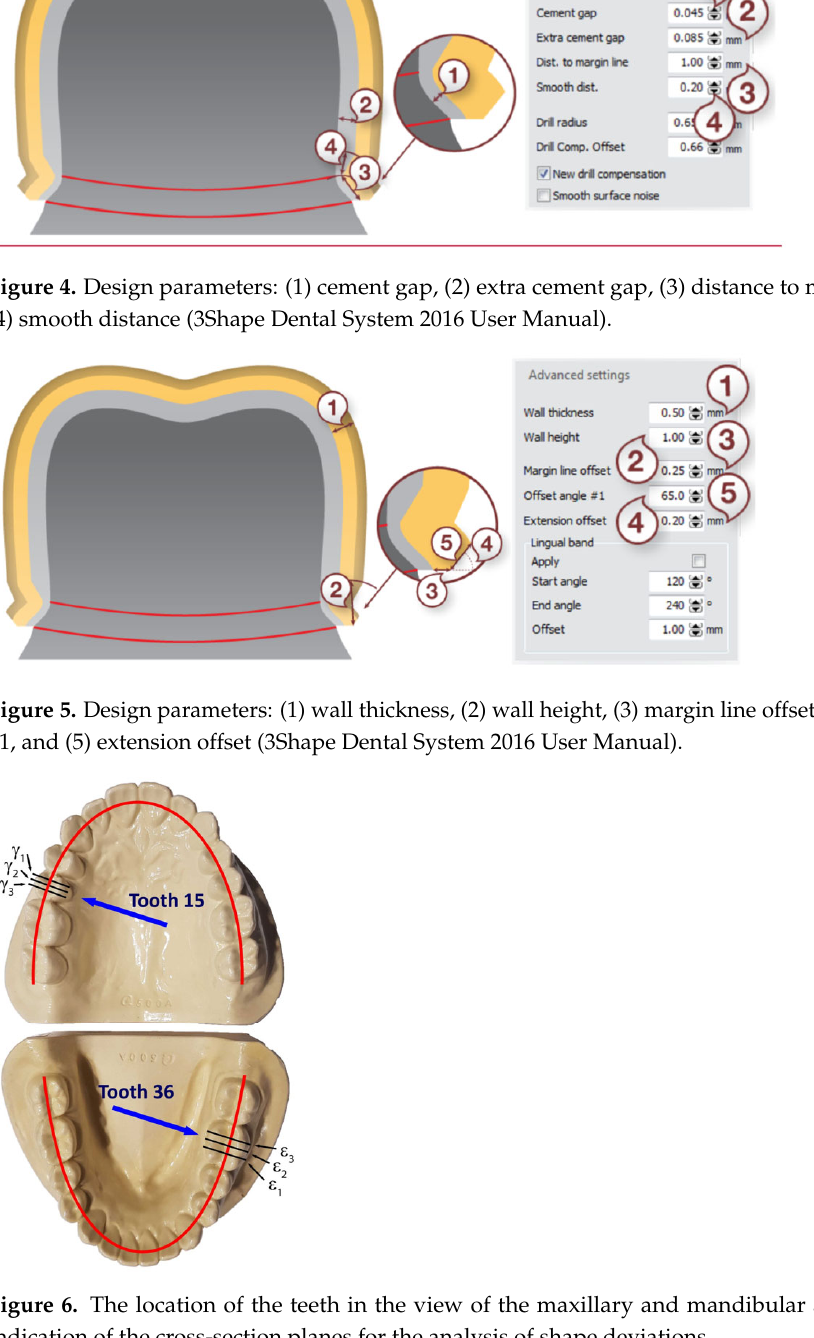
Figure 4. Design parameters: (1) cement gap, (2) extra cement gap, (3) distance to margin line, and